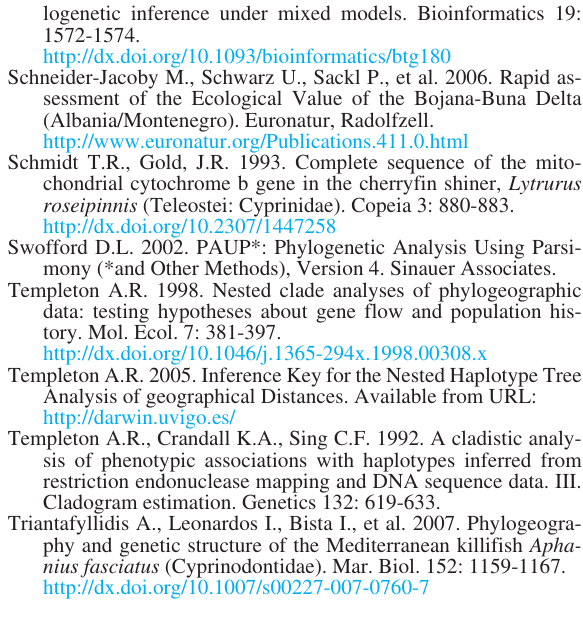
Table S1. – The list of localities of the origin of sequences retrieved from GenBank (N, number of sequences). Country codes: SLO, Slovenia; CRO, Croatia; MNE, Montenegro; ALB, Albania; ITA, Italy; MLT, Malta; TUN, Tunisia; GRE, Greece; ESP, Spain; ALG, Algeria; IRN, Iran. Table S2. – Haplotype frequencies for cyt B and mt DNA CR from the Adriatic localities. NG and SG explain populations belong- ing to the Northern and Southern groups, respectively